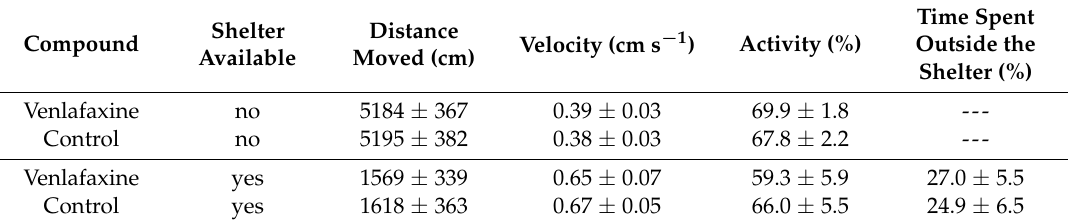
Table 3. The values of the distance moved, velocity, activity, and time spent outside the shelter in crayfish exposed to venlafaxine and in control crayfish, in set-ups with and without available shelter. Data are shown as mean ± standard deviation.